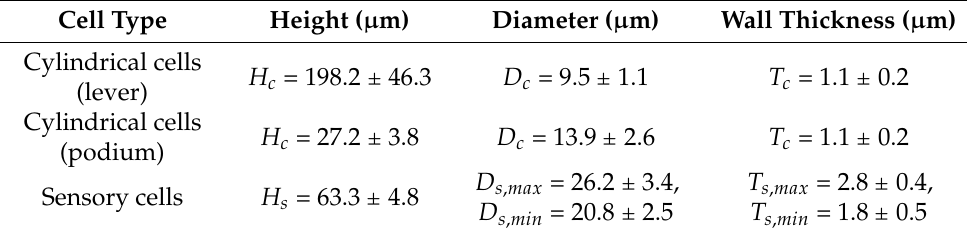
Figure 2. ( a ) Characteristic sections of the hair geometry denoted by normalized height h i and radius r i . The ∥ and ⊥ arrows correspond to the longitudinal and transverse directions. ( b ) Cylindrical cells in the lever ( blue ) and podium ( yellow ) with diameters D c , heights H c , and cell wall thickness T c . ( c ) Longitudinal section ( top ) of sensory cell with the inner lumen ( green ) having height H s and widths D s , max and D s , min . A magnified view of the notch is shown with features L 1,2,3,4 . The cross- sections ( bottom ), X-X and Y-Y, depict the cell’s opening angle θ and the wall thicknesses T s , min and T s , max . Table 2. Characteristic features of different